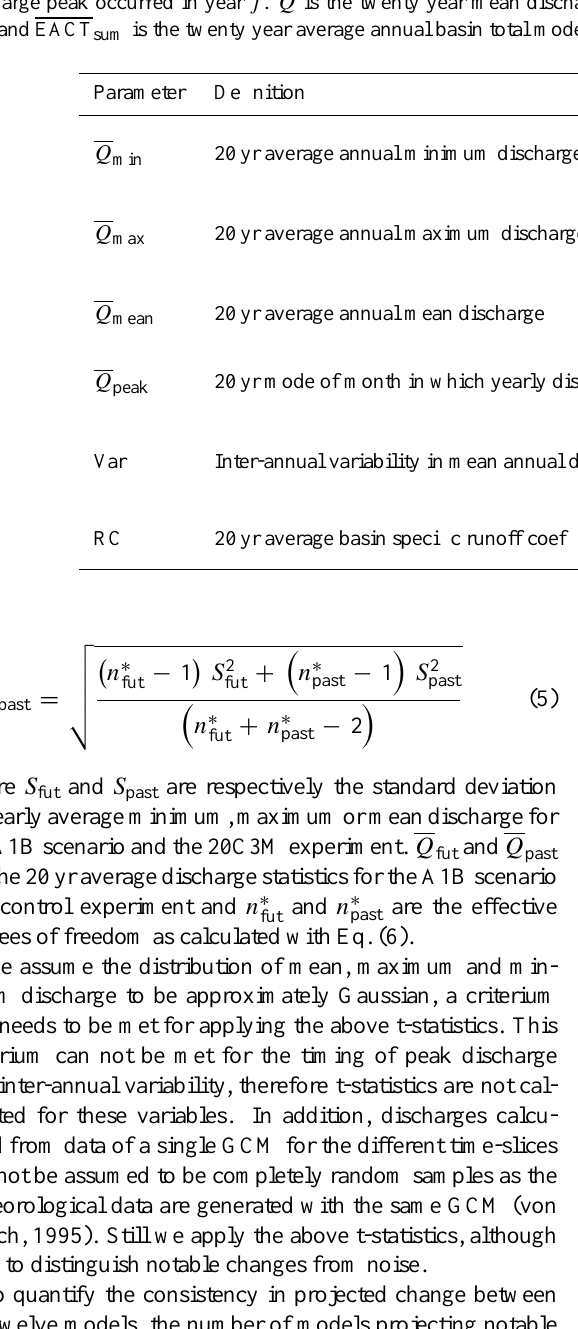
, Q min and Q max are respectively the mean, minimum and maximum daily discharge j j j is the number of the month in which j